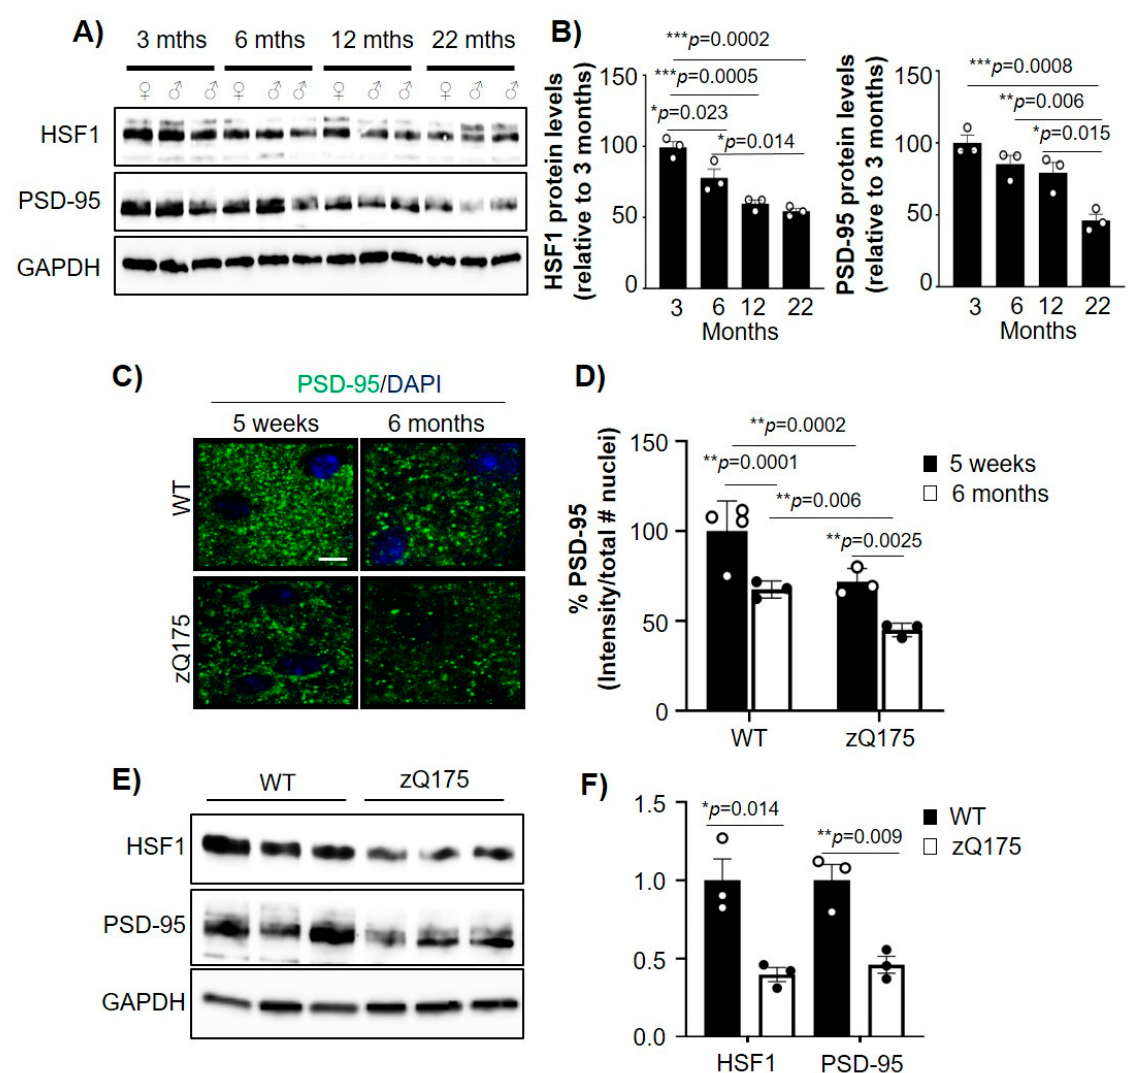
Figure 1. mtHTT exacerbates age-dependent down-regulation of HSF1 and PSD-95. ( A ) Immunoblot for HSF1 and PSD-95 from striatum samples from WT mice at different ages. GAPDH is used as a loading control. ( B ) HSF1 and PSD-95 protein levels quantified from A using ImageJ analyses. Data was normalized to GAPDH levels and relativized to 3 months ( n = 3 mice/genotype). ( C ) PSD-95 immunofluorescence in the striatum of WT and zQ175 mice. Scale bar 5 µ m. ( D ) PSD-95 intensity quantified by ImageJ from images in ( C ). Data was normalized to number of nuclei, relativized to 5 weeks WT, and shown as % PSD-95 signal ( n = 3–4 mice/genotype). ( E ) Immunoblotting for WT and zQ175 at 6 months ( n = 3 mice/genotype). GAPDH was used as a loading control. ( F ) HSF1 and PSD-95 protein levels quantified from ( E ) using ImageJ. Data was normalized to GAPDH levels and relativized to WT. Error bars denote mean ± SEM. One-way ANOVA with Tukey’s post-hoc correction in ( B ), two-way ANOVA with Tukey’s post-hoc correction in ( D ), and unpaired Student’s t -test in F. * p < 0.05, ** p < 0.01, *** p < 0.001, **** p < 0.0001. Only significant p -values are shown. Uncropped blots can be found in Supplementary materials (Supplementary Figure S3).